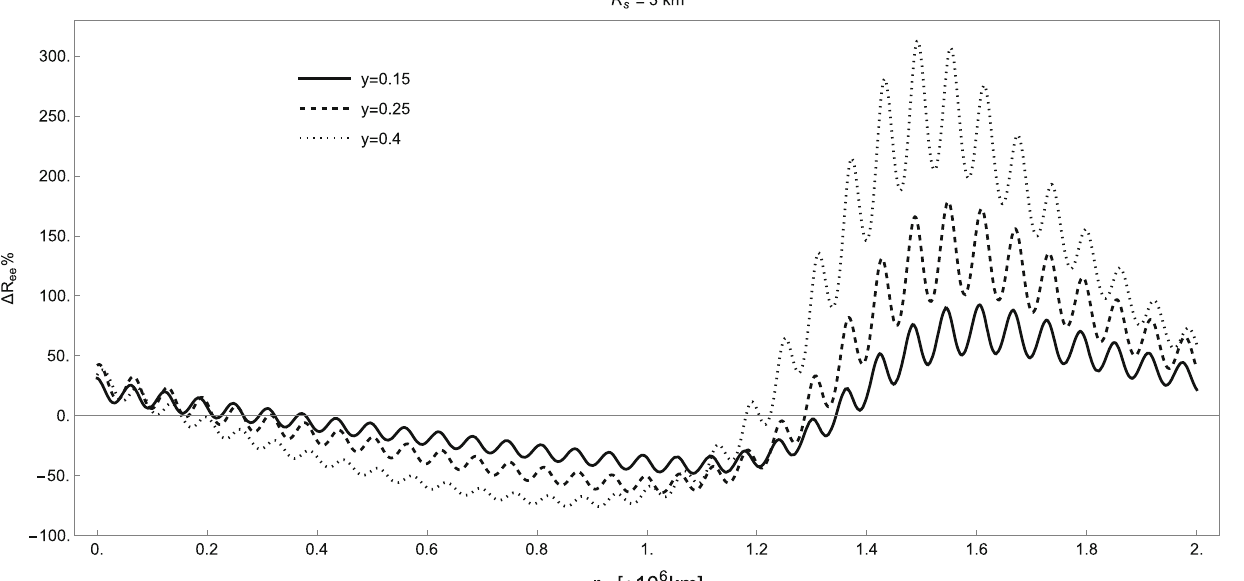
while the detector is located at r D = 10 13 km. Other parameters are = 0 . 4 E = 1 MeV. The values R s = 3 km, p T loc MeV/c, and E loc loc of neutrino mass squared differences, mixing angle and the Dirac CP phase are taken from the (NuFIT 5 (2020)) global fit [4]